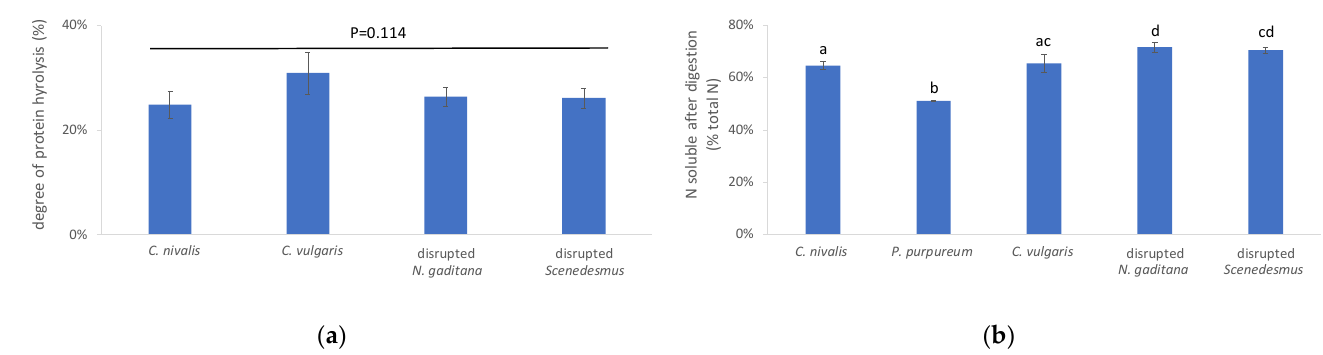
Figure 4. ( a ) N solubility after digestion, and ( b ) degree of protein hydrolysis after digestion. Values shown in the left panel are significantly different when bars are not labeled with a common letter. The type of algae biomass had no significant impact on the degree of protein hydrolysis (p = 0.114, 1-way ANOVA). The degree of protein hydrolysis could not be determined for P. purpureum. The nitrogen solubility after digestion was the lowest for P. purpureum (51.1 ± 0.1%) and significantly higher values were noted for C. nivalis and C. vulgaris (64.5 ± 1.5% and 65.5 ± 3.4%, respectively) and disrupted Scenedesmus and disrupted N. gaditana (70.4 ± 1.3%